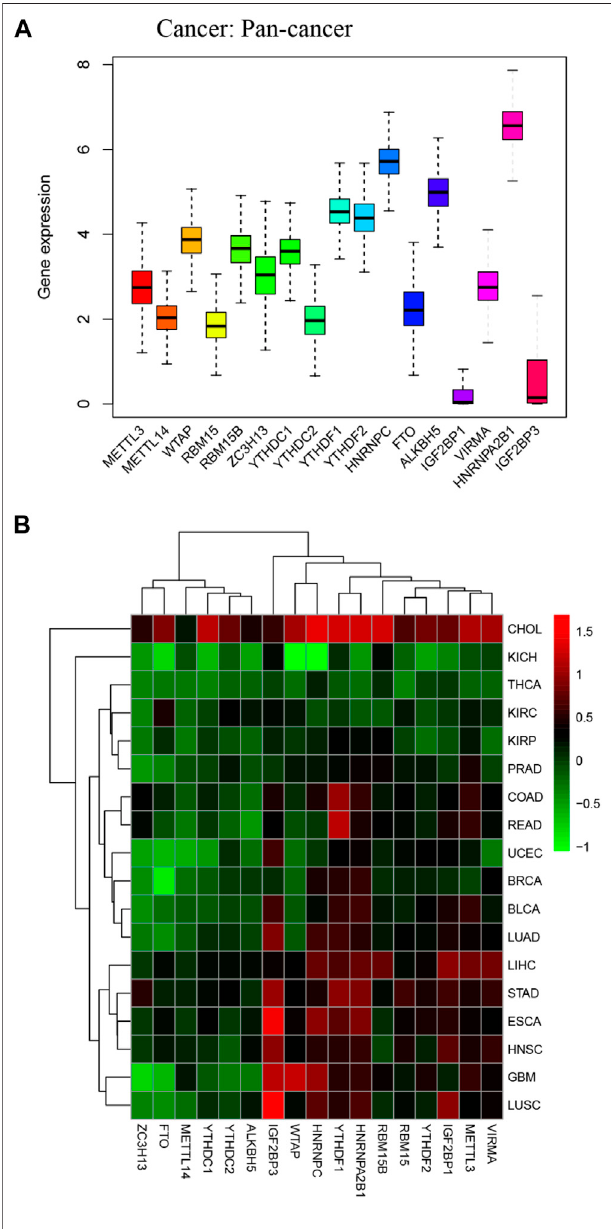
FIGURE2| Boxplotandheatmapof17m6Aregulatorsdifferentialexpression across 18 cancer types. (A) Boxplot of 17 m6A regulators expression in 18 TCGA cancer tissues. (B) The heatmap of 17 m6A regulators differential expression in 18 TCGAcancers. The red and green boxes indicatethattheexpression ofm6A methylation regulators is high and low in correspondence cancer,